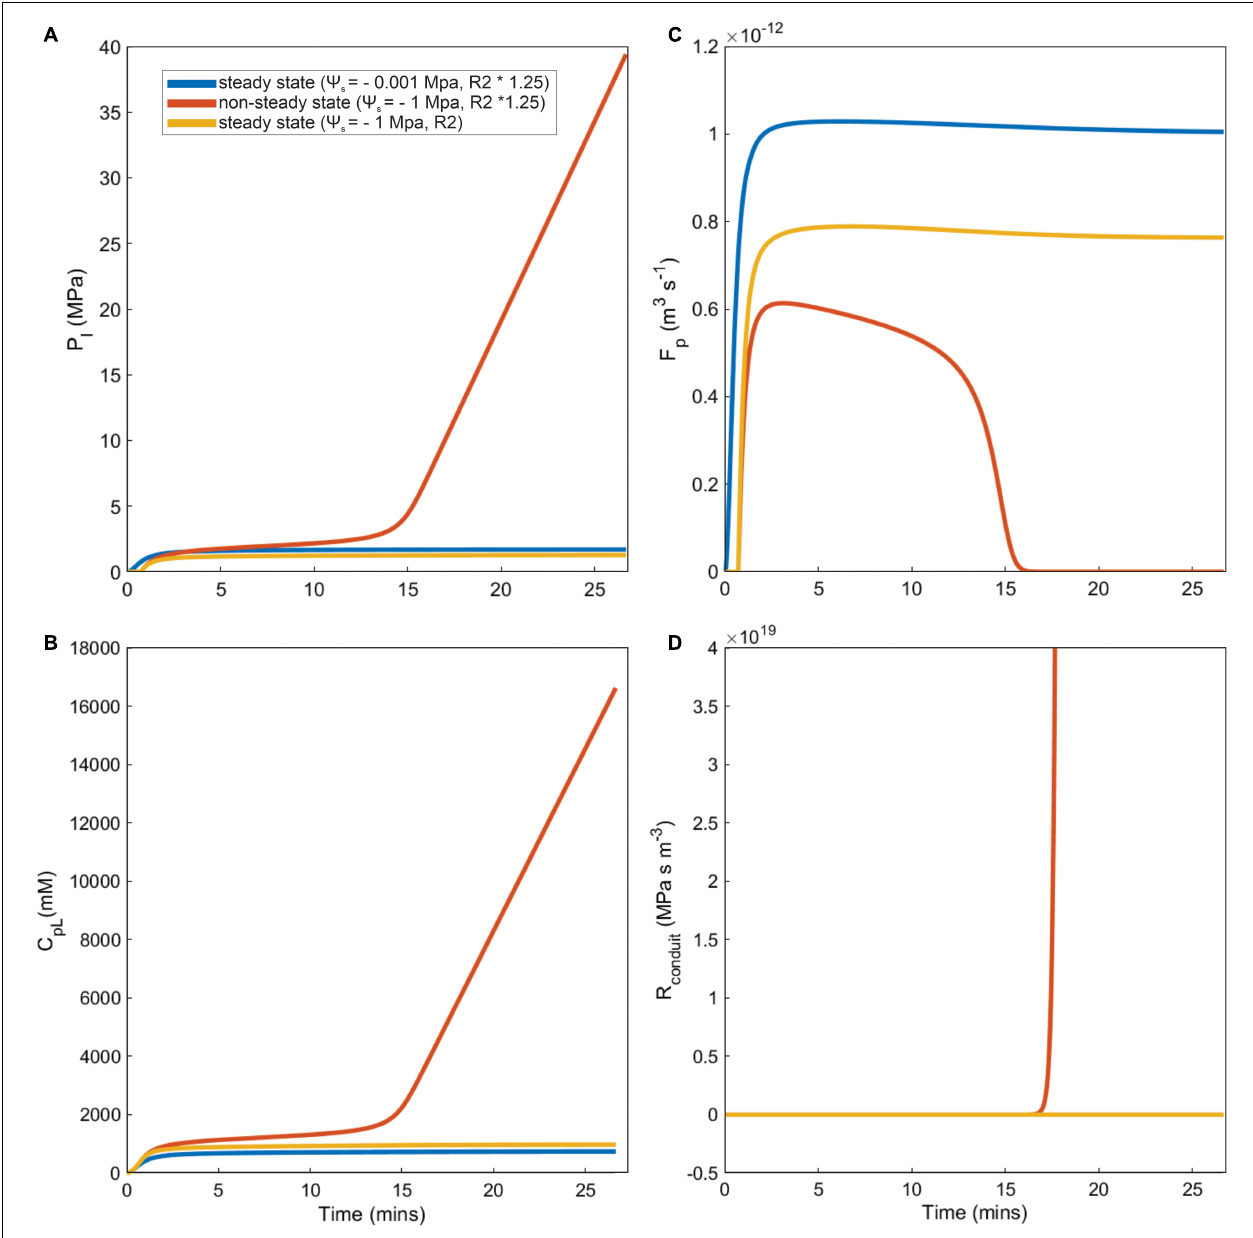
FIGURE 4 | Examples of steady state, and non-steady state simulations (caused by runaway viscosity) for different model outputs, over a subset of total simulation run time. Three scenarios represented by each line color are presented for differing soil water conditions ( (cid:57) s ) and phloem structural resistance (R2): First, a steady state wet and higher phloem pathway resistance simulation ( (cid:57) s = –0.001, R2 × 1.25, blue lines). Second, a non-steady dry and higher resistance phloem pathway simulation ( (cid:57) s = –1, R2 × 1.25, red lines). Finally, a steady state dry and lower resistance pathway simulation ( (cid:57) s = –1, R2, yellow lines). Each panel represents (A) Phloem pressure in the loading area (P l ), (B) concentration of sucrose in phloem loading area (C pL ), (C) phloem sap flow (F p ), and (D) total resistance of the phloem sieve tube conduit in the loading area, which considers fluid viscosity and phloem structural resistance (R conduit ).